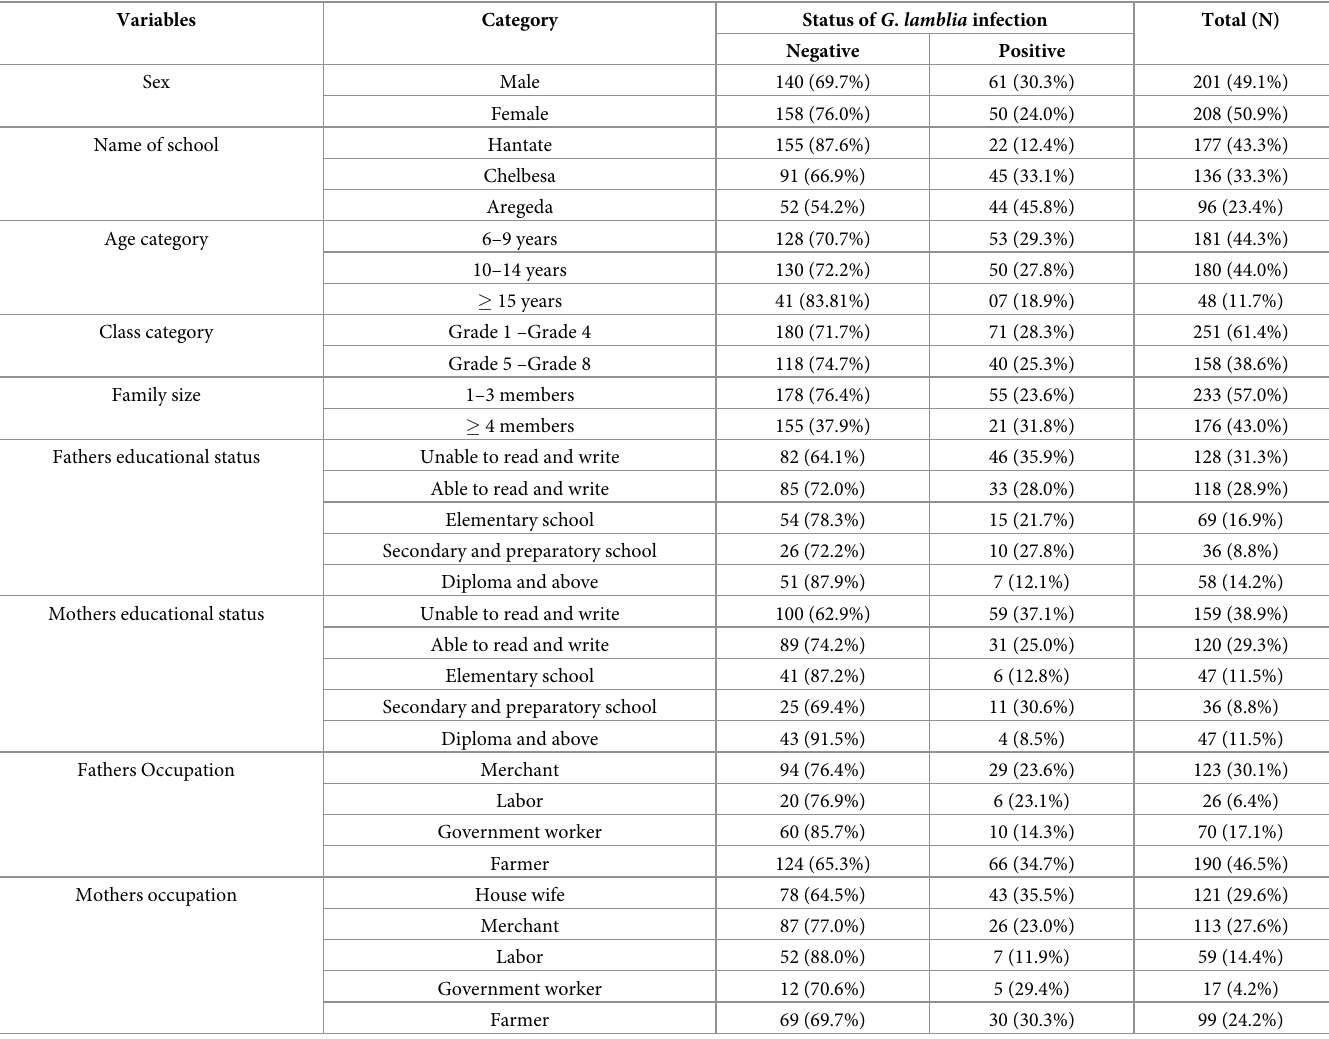
Table 2. Socio-demographic characteristics of government elementary school students of Lok Abaya town, Sidama zone, SNNPR,